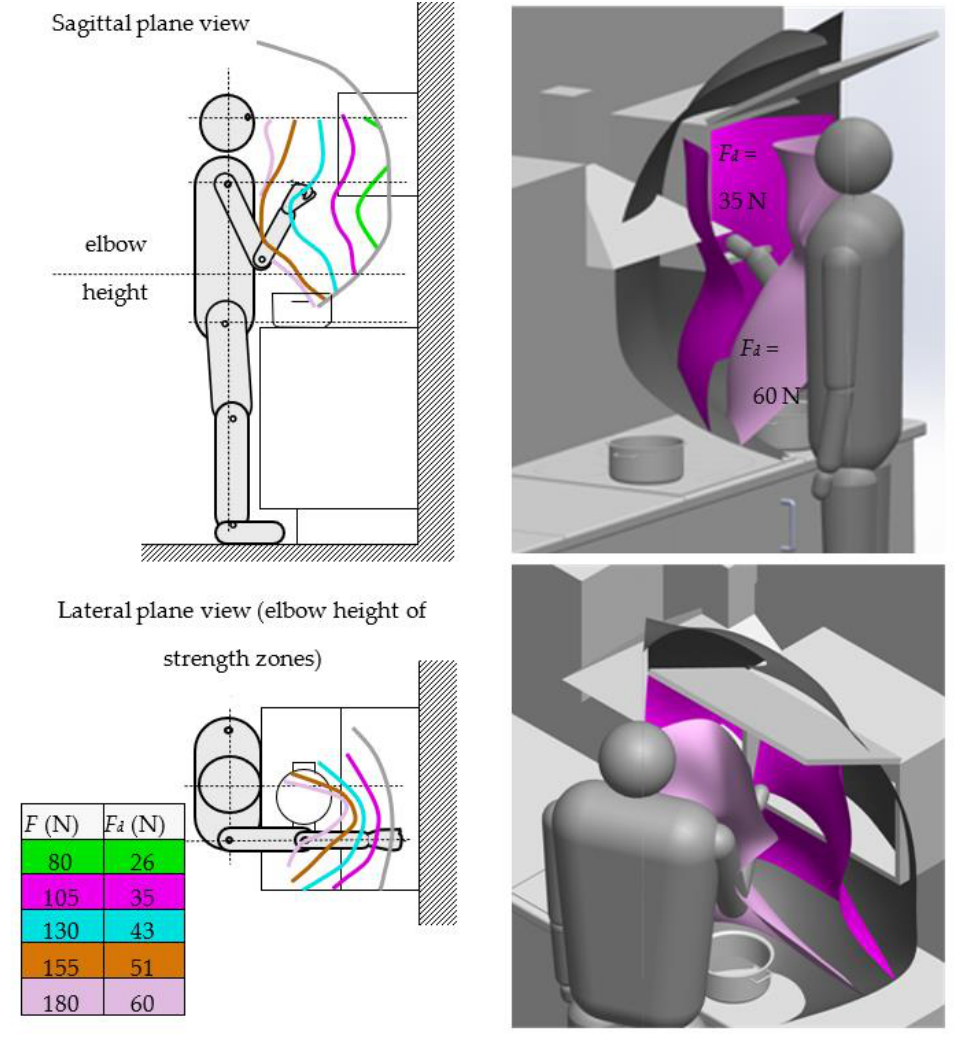
Figure 5. Visualization of the range zone and constant-strength space of the right limb during manipulation at the cooker and cabinets (two strength layers were used for testing) ( F —measured strength; F d — permissible strength).